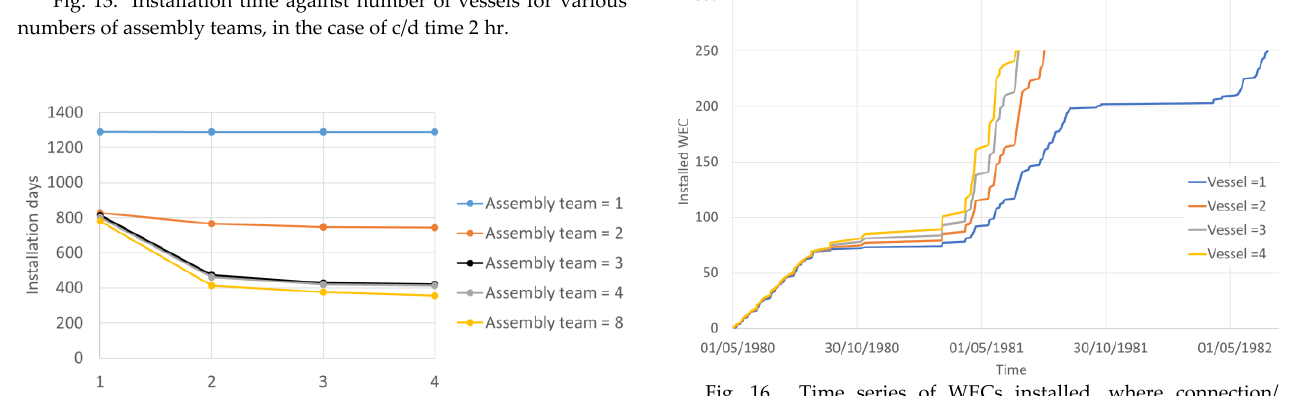
Fig. 13. Installation time against number of vessels for various numbers of assembly teams, in the case of c/d time 2 hr.